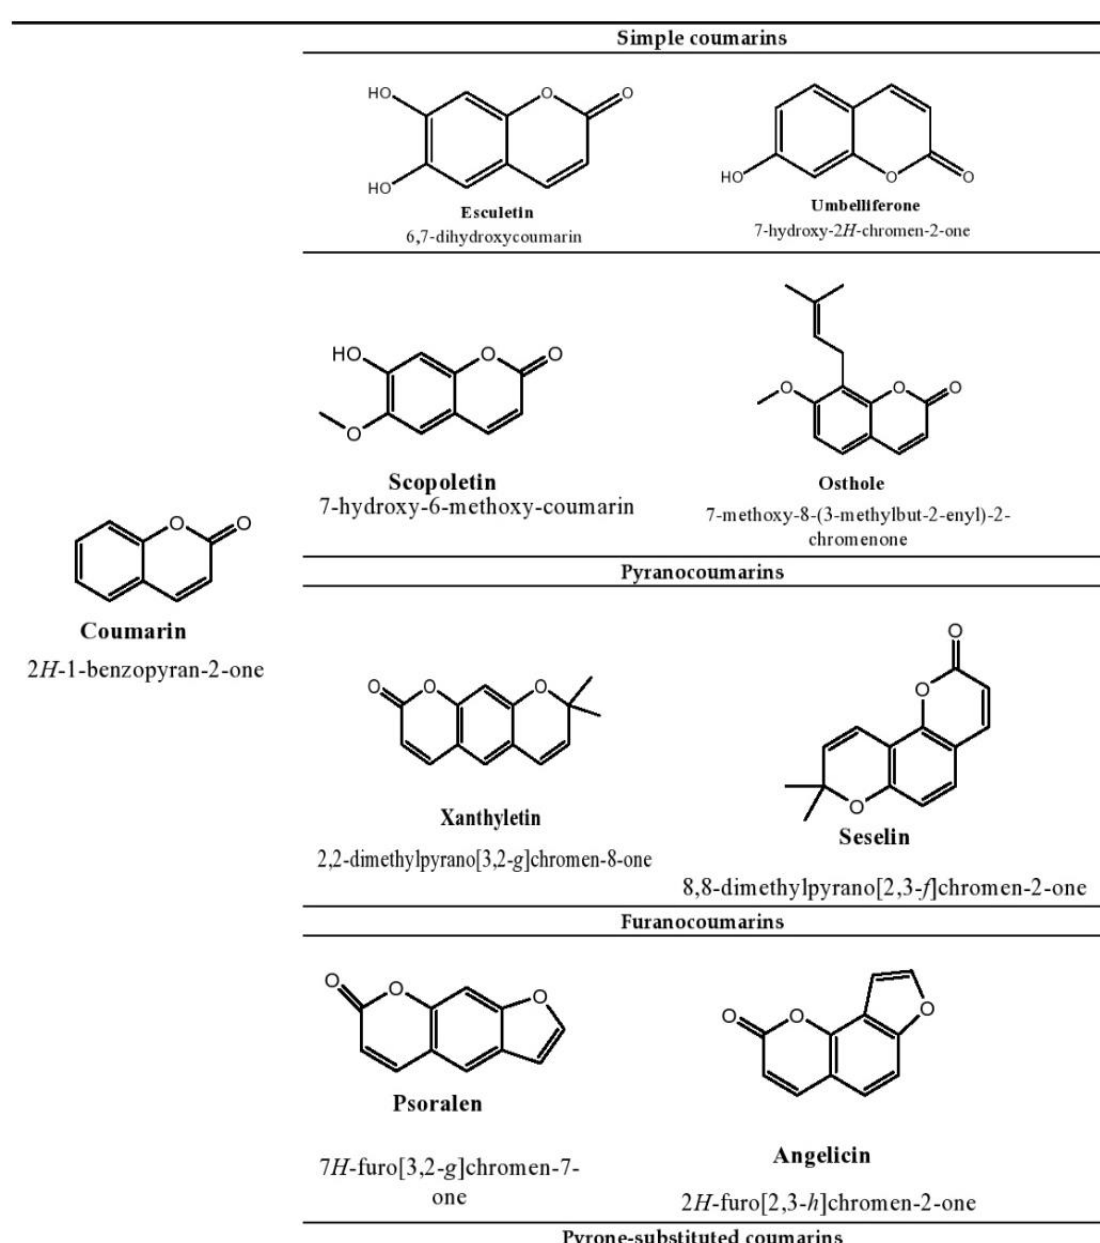
Figure 1. Structure of coumarin compounds.